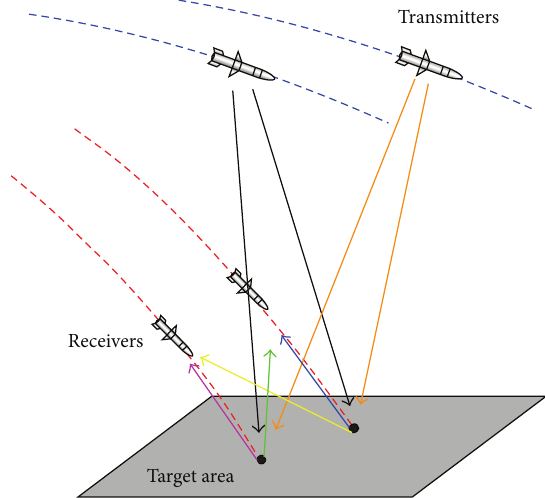
Figure 1: An illustration of MFL-SAR configuration.